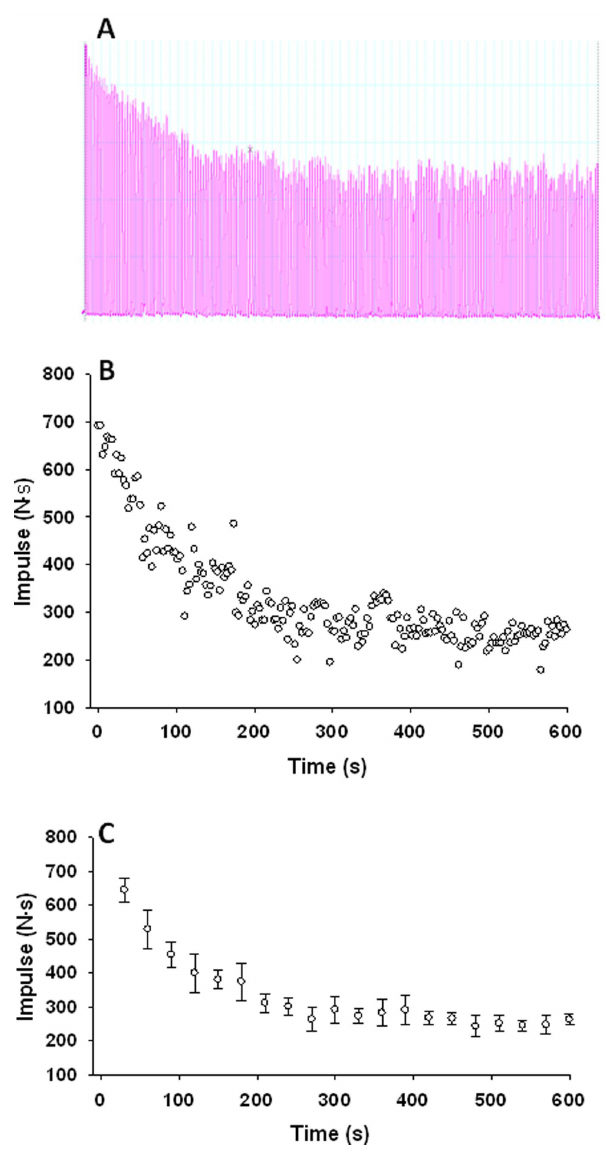
Figure 1. Force output during a 10 min maximal effort handgrip exercise test in a representative subject. Panel A: Raw force trace output Panel B: Impulse force of contraction plotted for all contractions during the test. Panel C: Impulse force averaged into 30 s time bins. Error bars indicate the contraction-to-contraction variability within each 30 s time bin.